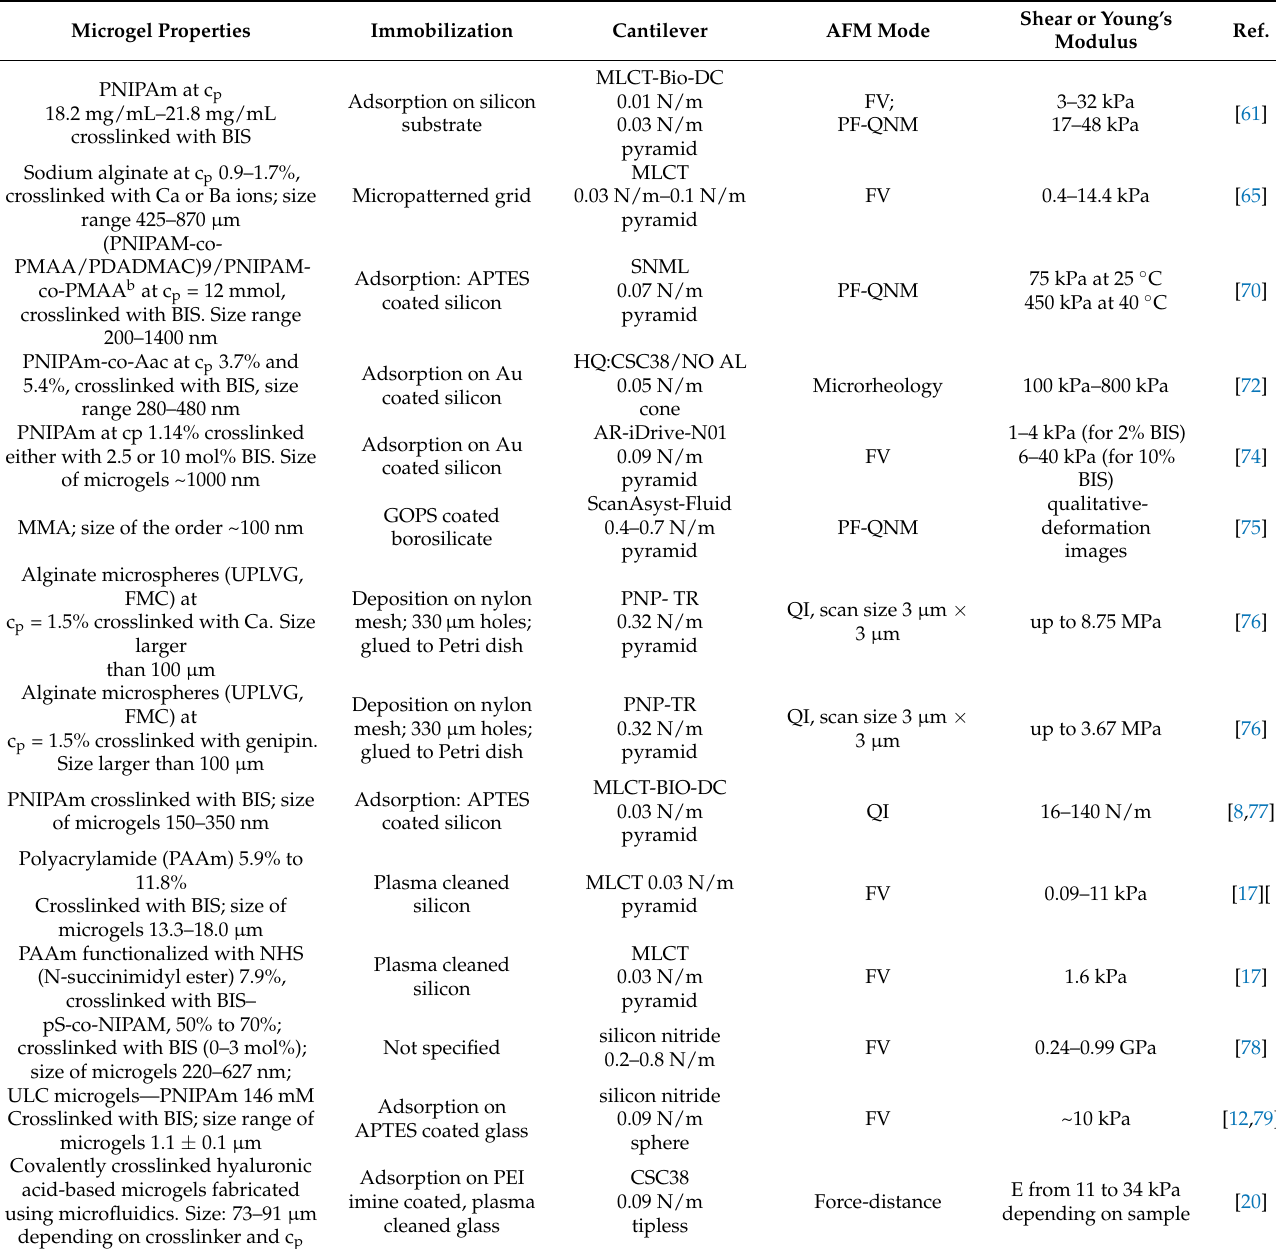
* Abbreviations used in the table: PNIPAm—poly( N -isopropylacrylamide); pS-co-NIPAM—poly(styrene-co- N -isopropylacrylamide); PVCL—poly( N -vinylcaprolactam; TBCHA—4-tert-butylcyclohexyl acrylate; co -PMAA— co -methacrylic acid; PDADMAC—poly- (diallyldimethylammonium chloride); PEG-PLPs—oligo ethylene glycol methacrylates with 4–5 ethyleneoxide repeating units and methacrylic acid; MMA—methacrylic acid; APTES—3-aminopropyl)triethoxysilane; GOPS—3-glycidoxypropyltrimethoxysilane; PBS— phosphate buffered saline; PAH—poly(allylamine hydrochloride); BIS— N , N ’-methylene-bis-acrylamide; AAc—acrylic acid; FV—force volume; PF-QNM—peak force quantitative nanomechanics; QI—quantitative imaging; PNIPAM-co-PMAA microgel/PDADMAC multi- layer